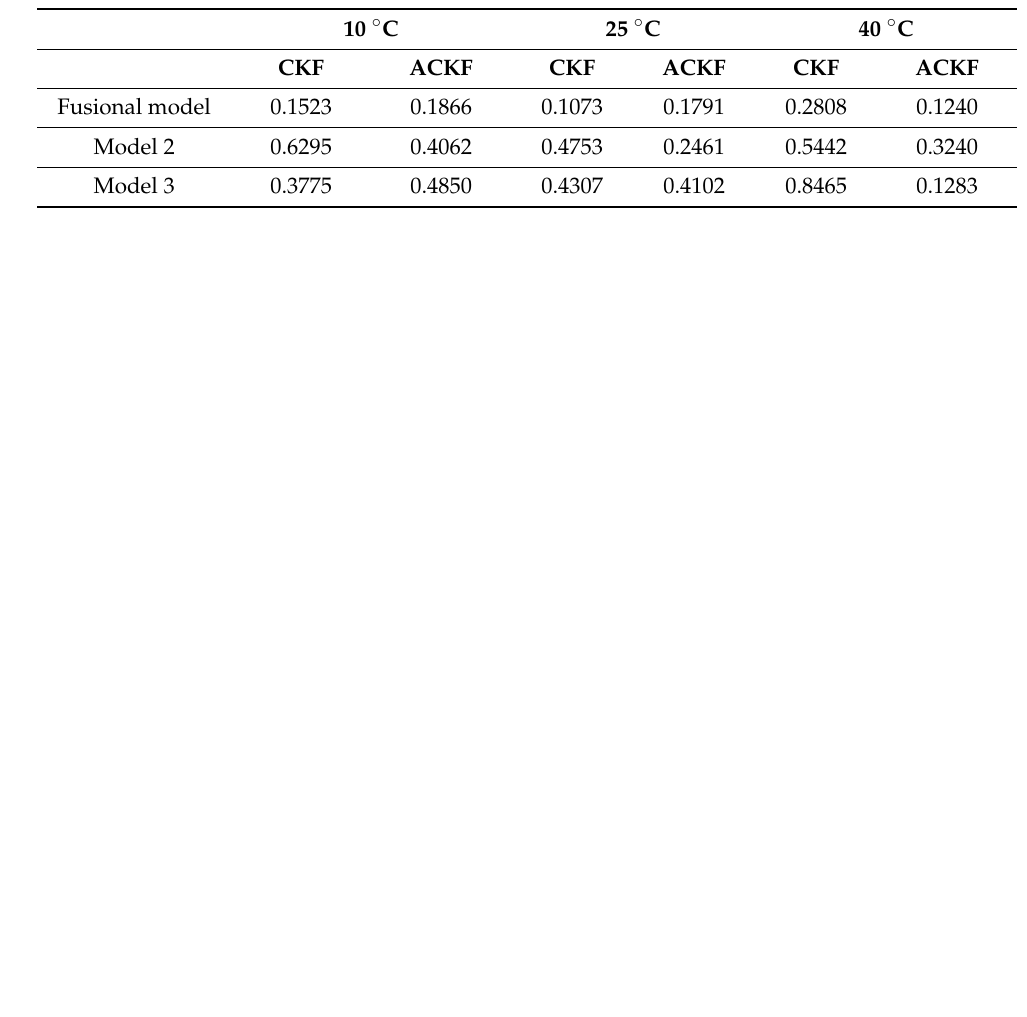
Table 10. RMSE of capacity estimation for LFP battery